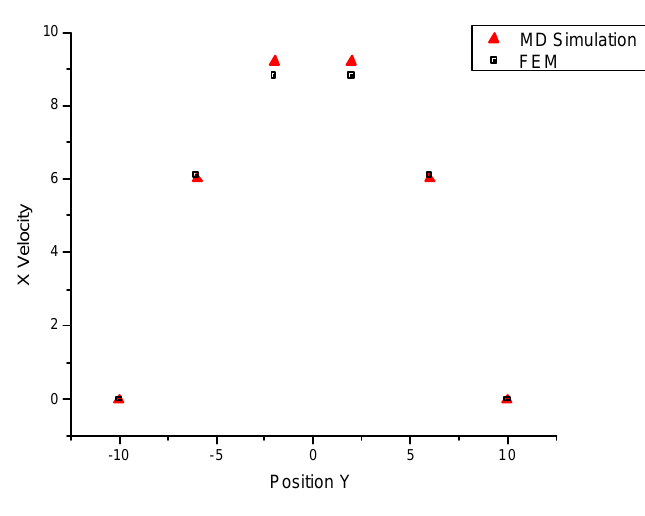
Figure 3. X velocity profile at position x=100 in Case 1